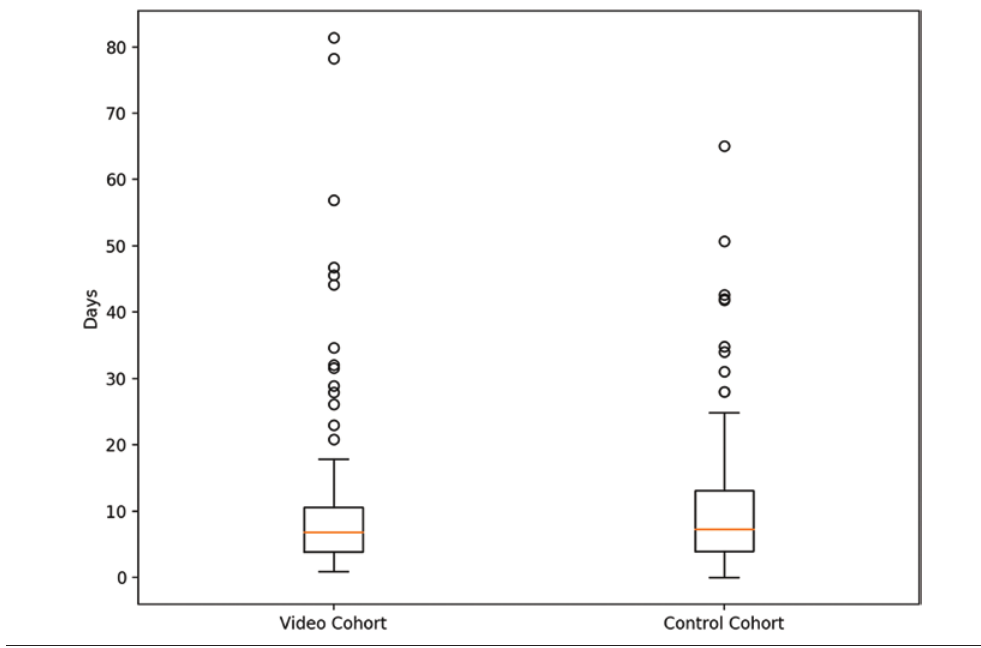
figure 6: comparison of the timespan (days) distribution between the checK and ReTeNTIoN questions for the TesT cohort (n = 172, median 6.8 days , IQR 6.7 days) and coNTRol cohort (n = 123, median 7.3, IQR 9.1 days) (source: author)